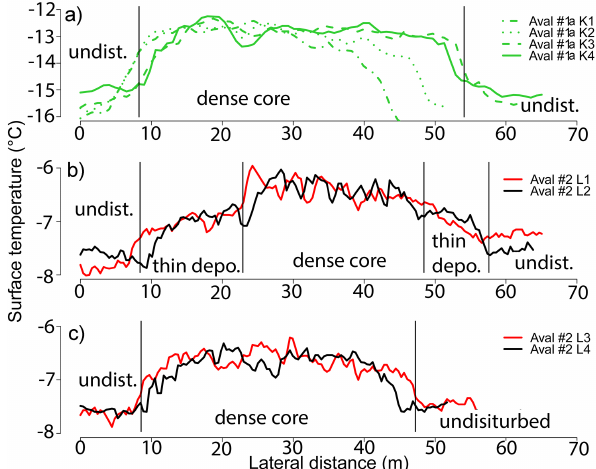
Figure 7. Snow surface temperatures acquired with IRT along lat- eral transects for avalanche #1 (a) and in the path (b) and the depo- sition area (c) of avalanche #2. Extent of undisturbed snow cover, thin-deposit and dense core are indicated. The lateral distance was calculated by referencing and scaling with the measured width of the